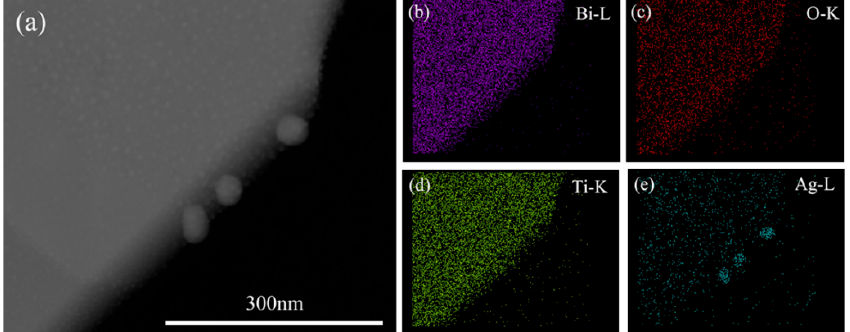
Figure 5. TEM image ( a ) and EDS maps of Bi, O, Ti and Ag ( b – e ) of as-prepared Ag 0.001 /Bi 4 Ti 3 O 12 .